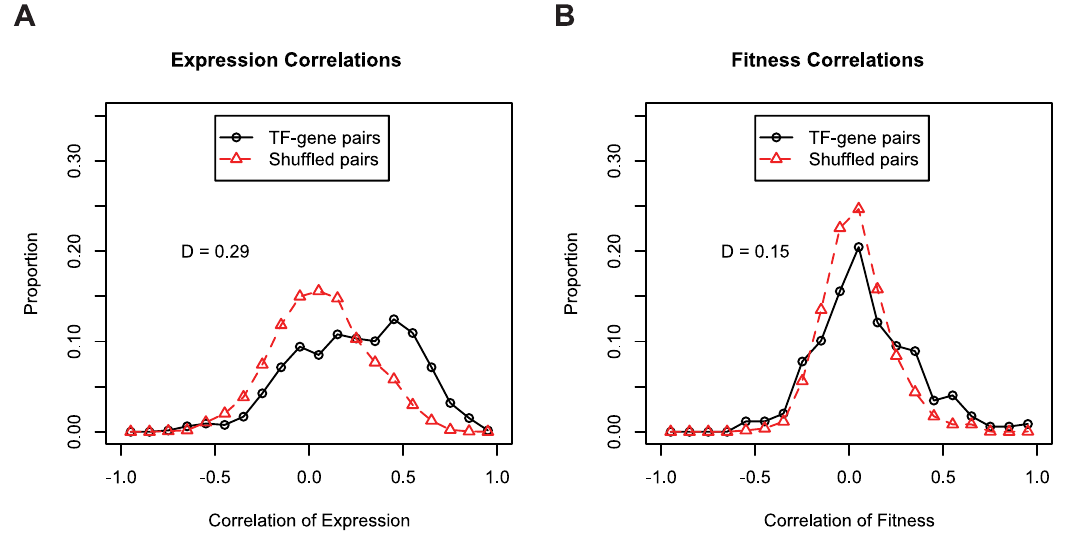
Figure 8. Expression and fitness are both informative about gene regulation. (A) Coexpression of transcription factors and their predicted target genes. All transcription factor-target gene pairs are derived from the manually curated RegPrecise database [41]. We excluded autoregulatory pairs from both the RegPrecise gene pairs and the shuffled controls. The same 371 expression experiments described in Figure 7B are used. (B) Same as A, using cofitness rather than coexpression. For fitness correlations, the entire fitness compendium of 195 experiments was used.